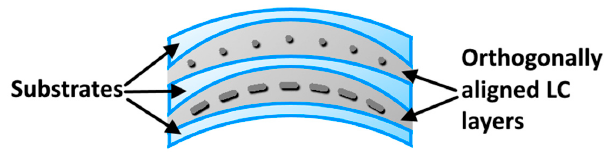
Figure 15. Negative meniscus substrates encapsulating orthogonally aligned positive meniscus LC layers to achieve a polarization independent device.